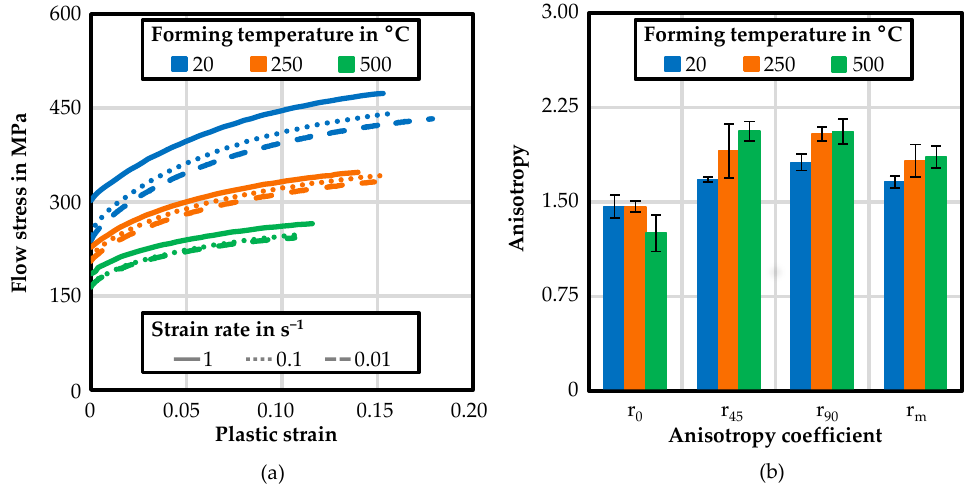
Figure 5. Experimental temperature and strain-ate- dependent flow curves at 0° to the rolling direction ( a ); and temperature-dependent anisotropy coefficients ( b ) for HX220 at a 1.2 mm sheet thickness.